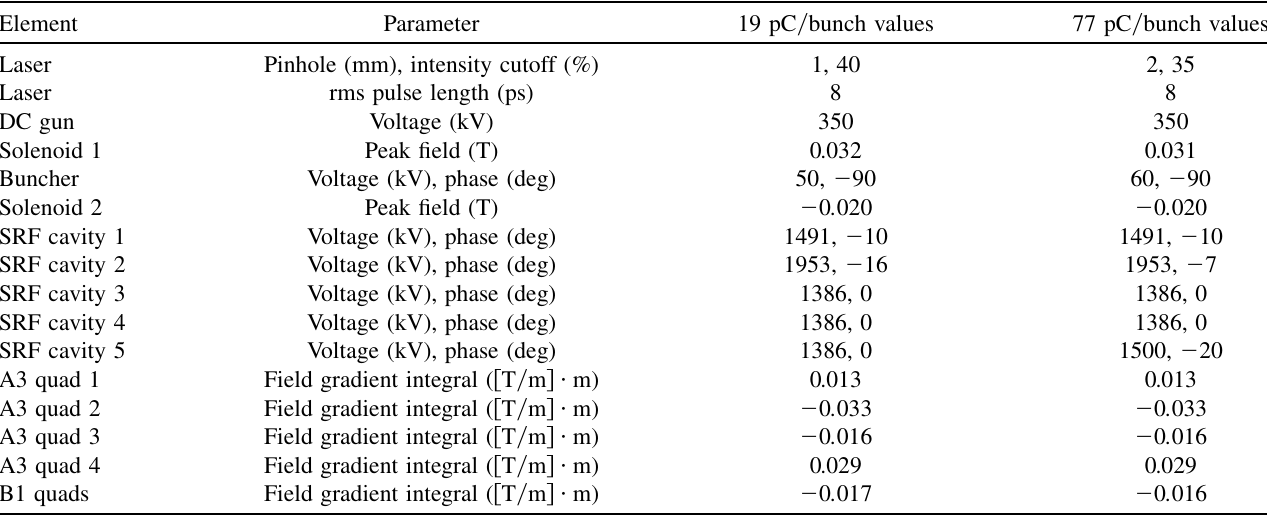
TABLE II. Relevant injector settings used for measurements with nonzero space